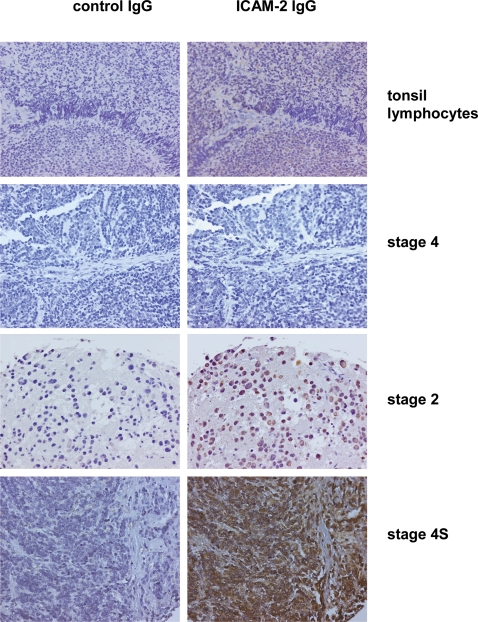
Immunohistochemical analyses ICAM-2 expression with a tissue microarray containing primary tumor specimens from 90 individual patients showed that a relatively high level of ICAM-2 expression was associated with primary tumor cells recognized to have limited metastatic potential.ICAM-2 antibody binding was detected using a peroxidase-tagged secondary antibody and DAB substrate (brown), by standard methods. Specimens were counterstained with hematoxylin/eosin, to visualize morphology of tumor and stromal cells. Staining was scored as: percent of stained cells×staining intensity (0, 1+, 2+, or 3+). The scores for ICAM-2 expression of the Stage 4, Stage 2, and Stage 4S tumor specimens pictured were 0, 270, and 300, respectively. Normal lymphocytes (a positive control) received a score of 100 (100% of lymphocytes×a staining intensity of 1+). Each specimen is described in more detail in the text.